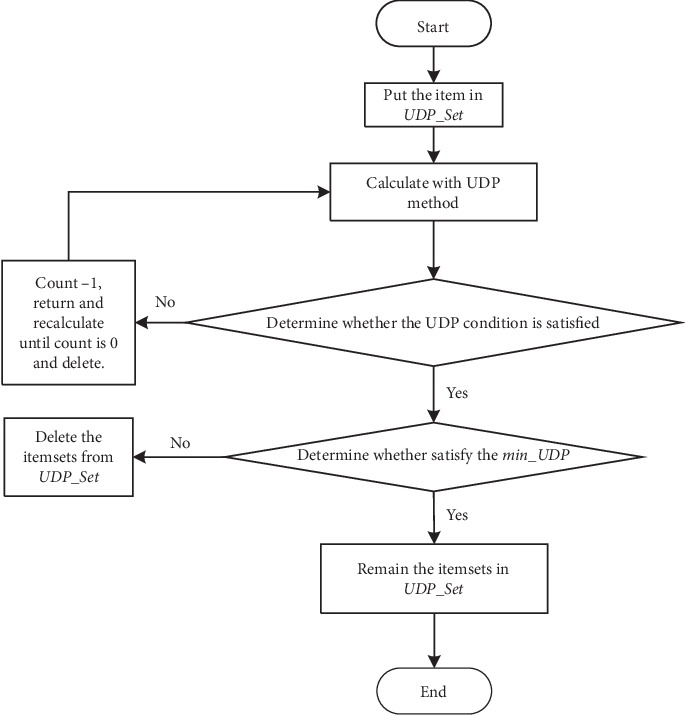
The flowchart of UDP method in Figure 1.